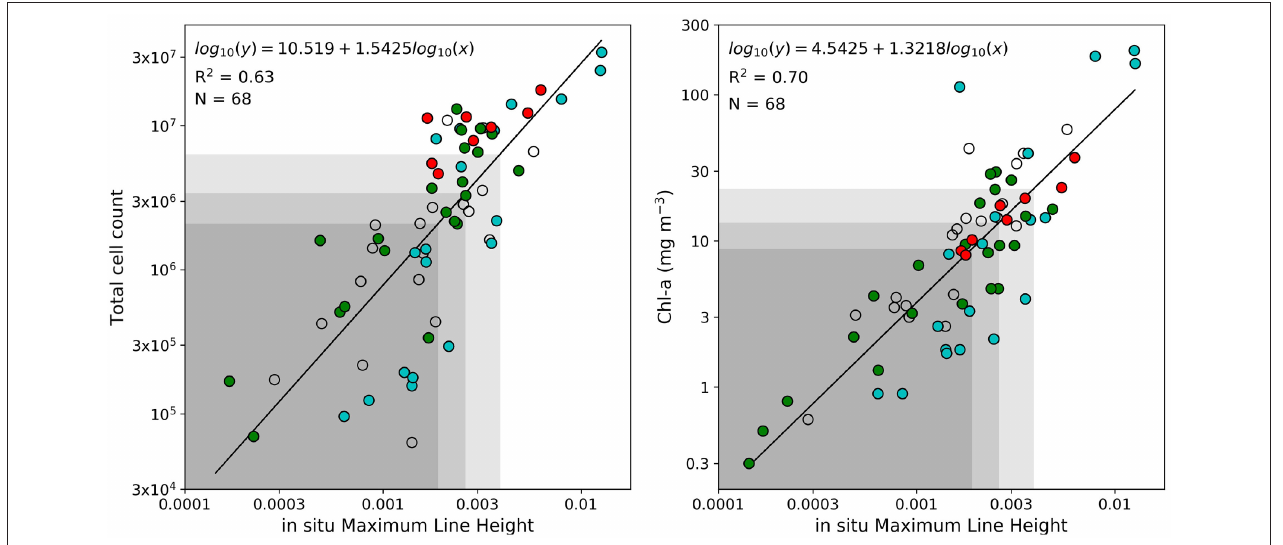
FIGURE 4 | Linear regression analysis between maximum line height and total cell counts (left) and between maximum line height and [Chl-a] (right) ; all data were log-transformed before analysis. The black line represents the regression line with the corresponding equation, coefficient of determination ( R 2 ) and the sample size ( N ). Samples with more than 50% Pseudo-nitzschia , diatoms, or dinoflagellates are shown in red, green, and blue, respectively. The shaded areas represent cell counts and [Chl-a] associated with MLH below 0.0019, 0.0027, and 0.0038,